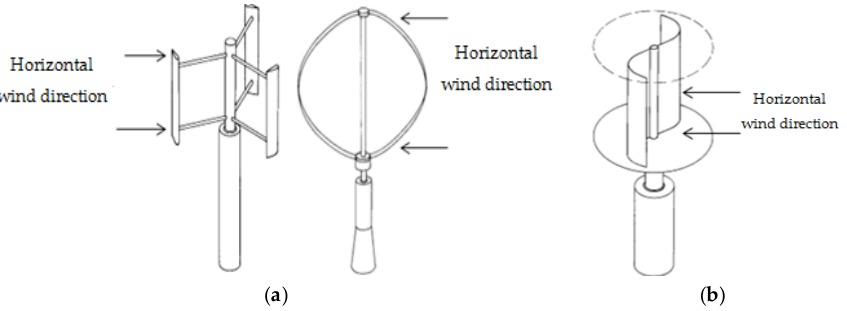
Figure 2. Two distinct types of VAWT operating under any horizontal wind direction [24]. ( a ) Darrieus rotors; ( b ) Savonius rotor.